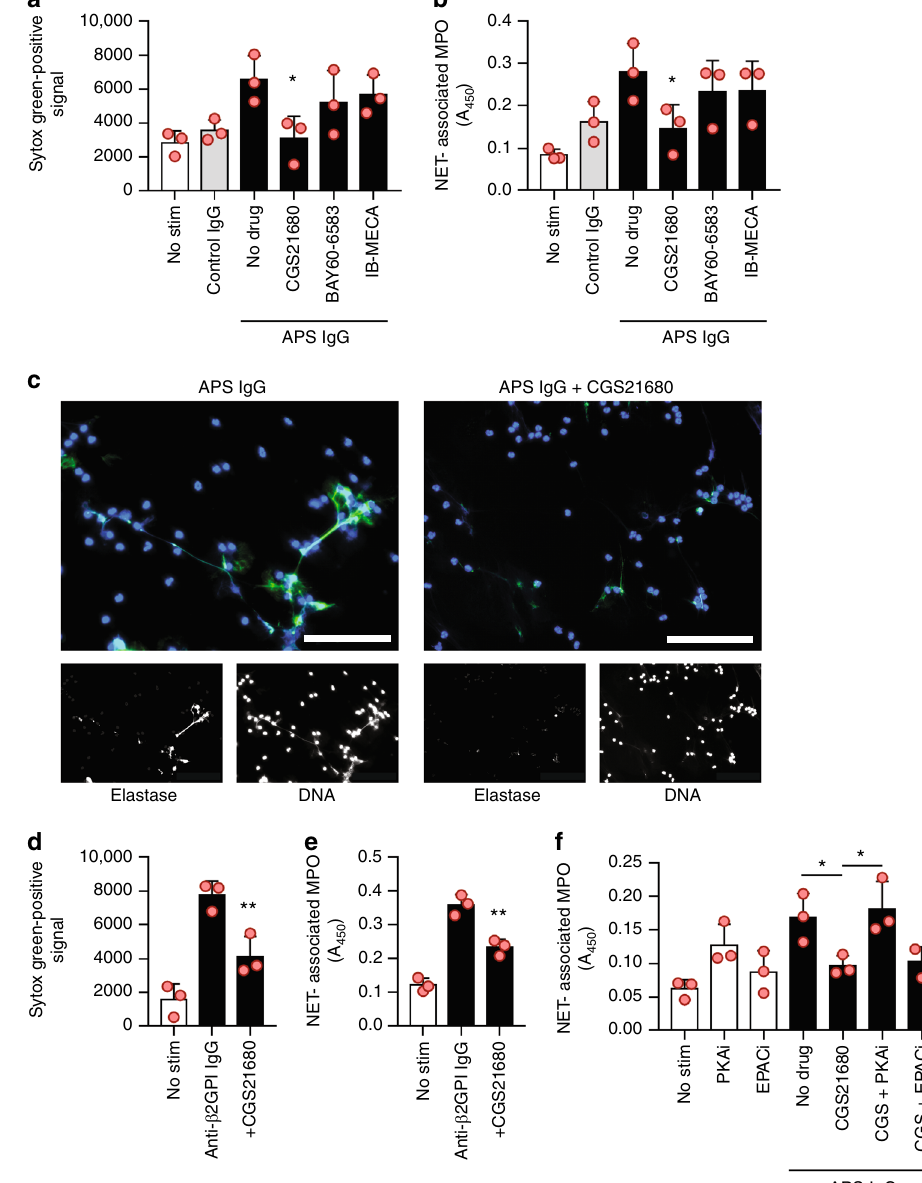
Fig. 2 Agonism of the adenosine A 2A receptor suppresses NETosis. a , b Neutrophils were isolated from healthy volunteers and then treated with either control IgG or APS IgG for 3 h. Some samples were additionally treated with agonists of the adenosine A 2A receptor (CGS21680), A 2B receptor (BAY60- 6583), or A 3 receptor (IB-MECA) as indicated. In panel a , total extracellular DNA was measured as relative fl uorescence units upon the addition of Sytox Green. In panel b , an independent set of experiments was performed, with NETosis quanti fi ed by measuring the enzymatic activity of nuclease-liberated myeloperoxidase (MPO). Mean and standard deviation are presented for n = 3 independent experiments; * p < 0.05 as compared with the APS IgG/no- drug group by one-way ANOVA corrected with Sidak ’ s test. c NETosis was assessed qualitatively by immuno fl uorescence microscopy. Blue = DNA, green = extracellular neutrophil elastase, and scale bar = 100 microns. d , e Neutrophils were treated with af fi nity-puri fi ed anti- β 2 GPI IgG (black bars) in the presence or absence of the A 2A receptor agonist. Extracellular DNA ( d ) or NETs ( e ) were quanti fi ed as above. Mean and standard deviation are presented for n = 3 independent experiments; ** p < 0.01 as compared with the no-drug group by one-way ANOVA corrected with Dunnett ’ s test. f Neutrophils were treated with APS IgG (black bars) in the presence of a protein kinase A inhibitor (PKAi) or an inhibitor of the exchange protein activated by cyclic-AMP pathway (EPACi) as indicated, and NETs were quanti fi ed. Mean and standard deviation are presented for n = 3 independent experiments; * p < 0.05